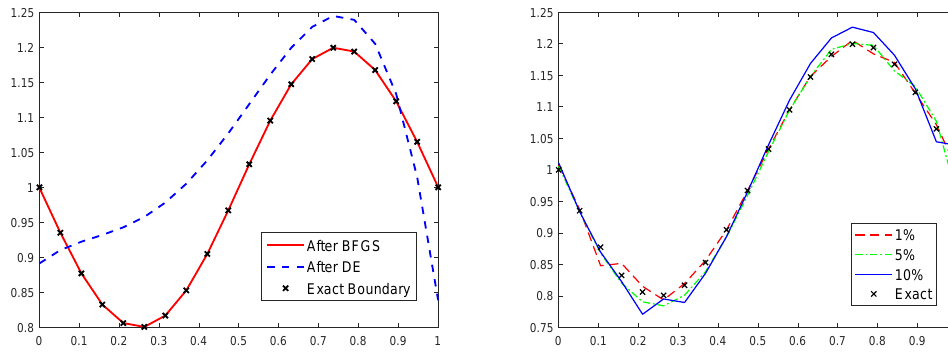
Figure 2. Results for example 1 without noise ( left ), with different noise level ( right ).